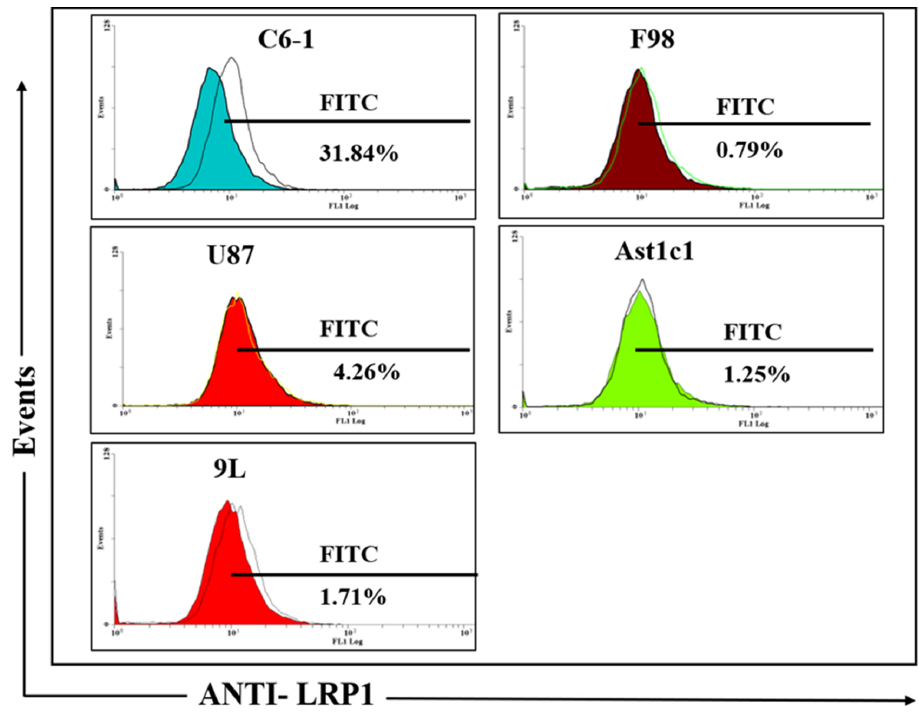
Figure 3. LRP1 expression studies on glioma cell lines. Histogram overlays of the corresponding cell populations (LRP1-null cells and anti-LRP1-antibody-labeled cells). Left, control LRP1-null cells (shaded) and anti-LRP1-antibody-labeled cells (lines). The histogram shows the percentage of FITC fluorescence. Flow cytometry quantified the values on histogram markers to represent the percent of cells positive for FITC fluorescence (FL1).